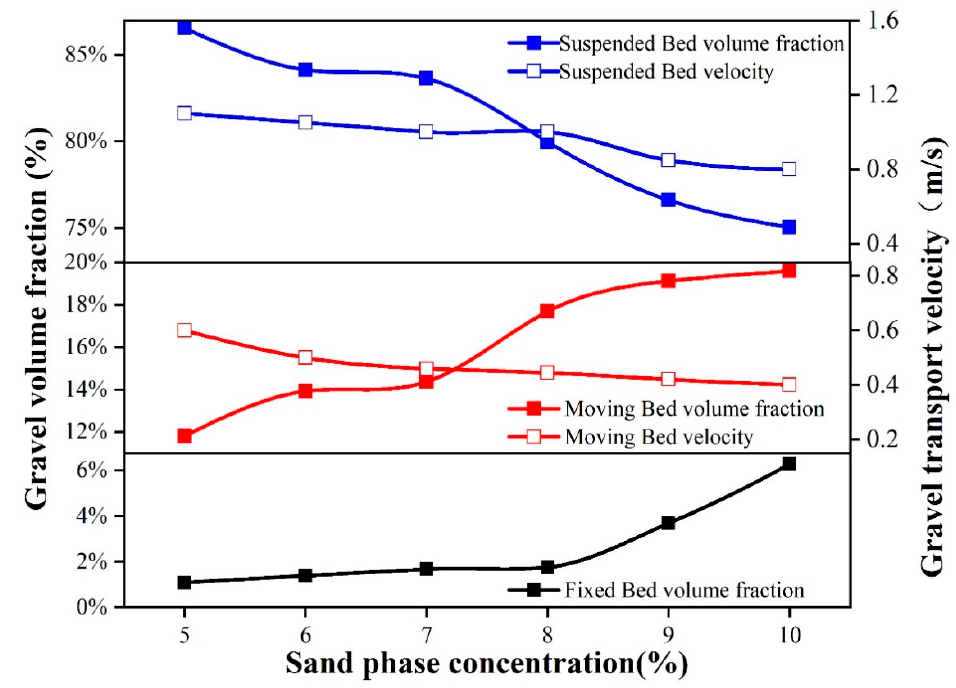
Figure 16. Graph of the effect of carrying ratio on the volume fraction and migration velocity.